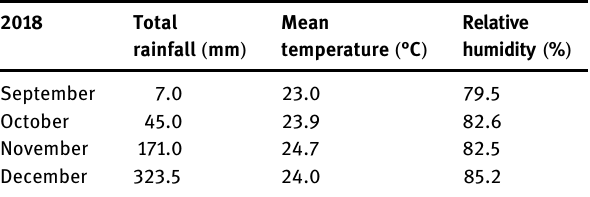
Table 1: Meteorological data for KALRO, Kiboko, research